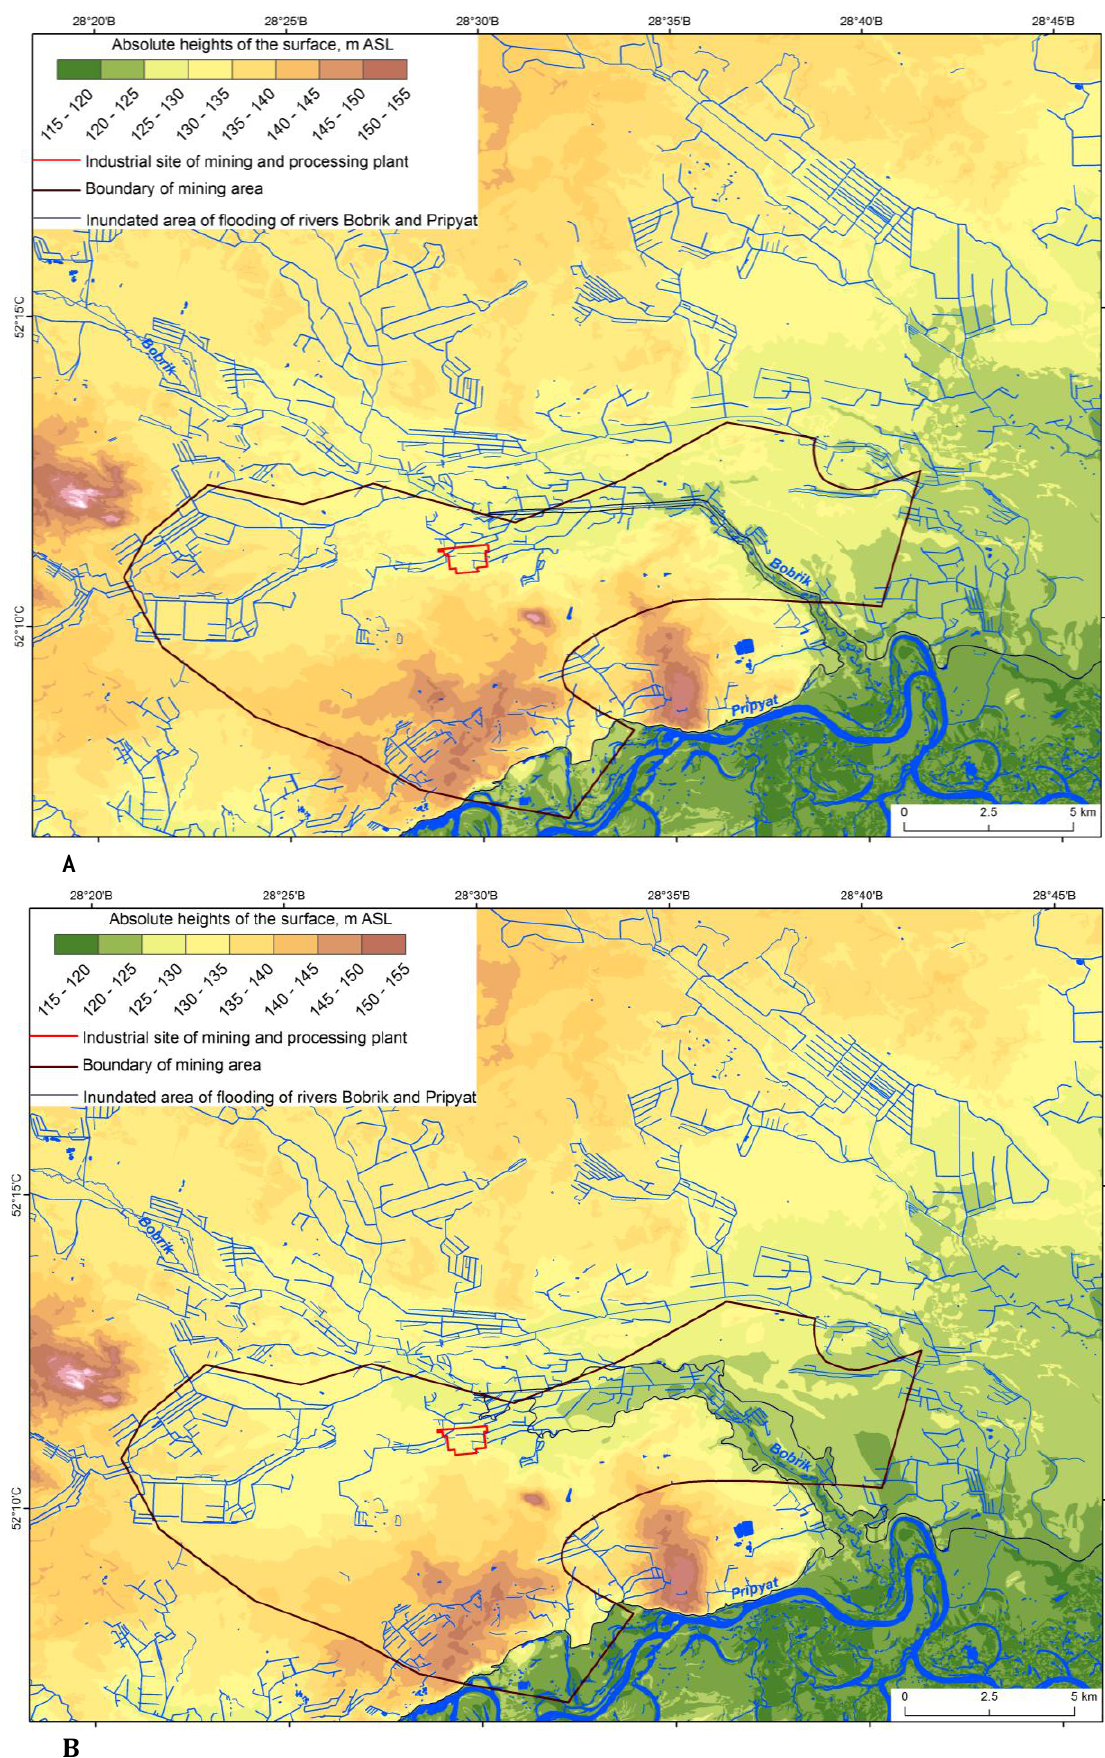
Fig. 2. Topography and surface hydrology of the study area under natural priorities (A) and after (B) impact of